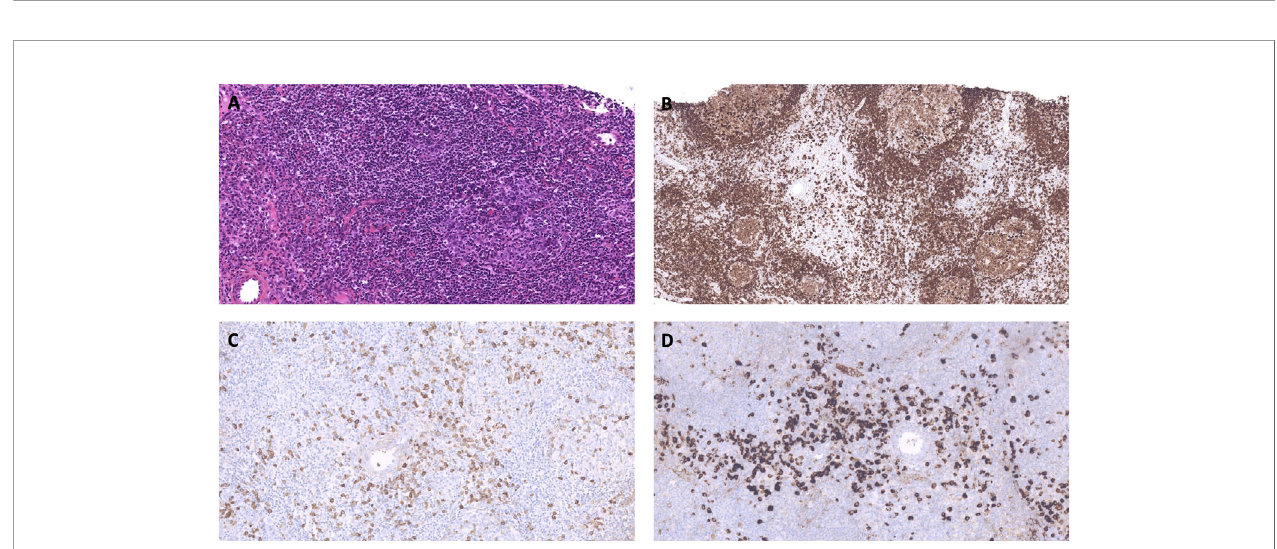
FIGURE 2 | Representative images of the axillary lymph node biopsy histological examination. (A) Lymph node showing reactive follicular hyperplasia. The reactive follicle comprises germinal center surrounded by a thin mantle zone. The interfollicular area contains numbers of mature plasma cells. Hematoxylin and Eosin staining x400. (B) Lymph node showing reactive follicular hyperplasia and mature plasma cells. CD79a staining. (C , D) IgG (C) and IgG4 (D) staining. Numerous IgG4 + cells are present between follicles. The IgG4 + /IgG + cell proportion is over 40%, with more than 200 IgG4 + cells per high power fi